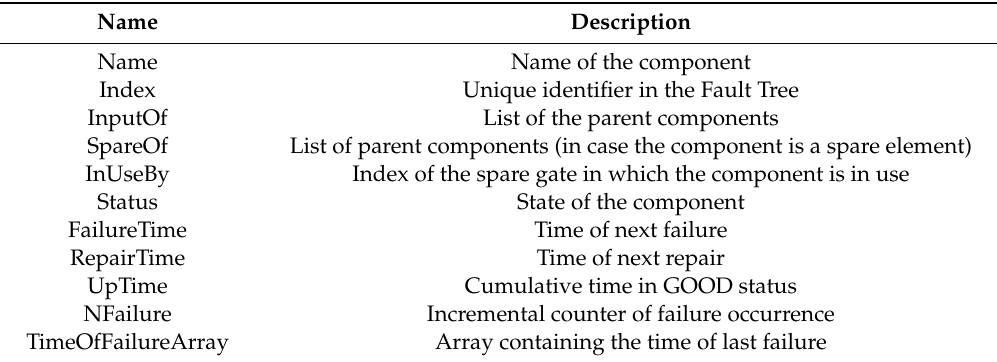
Table A6. Attributes of the Gates.